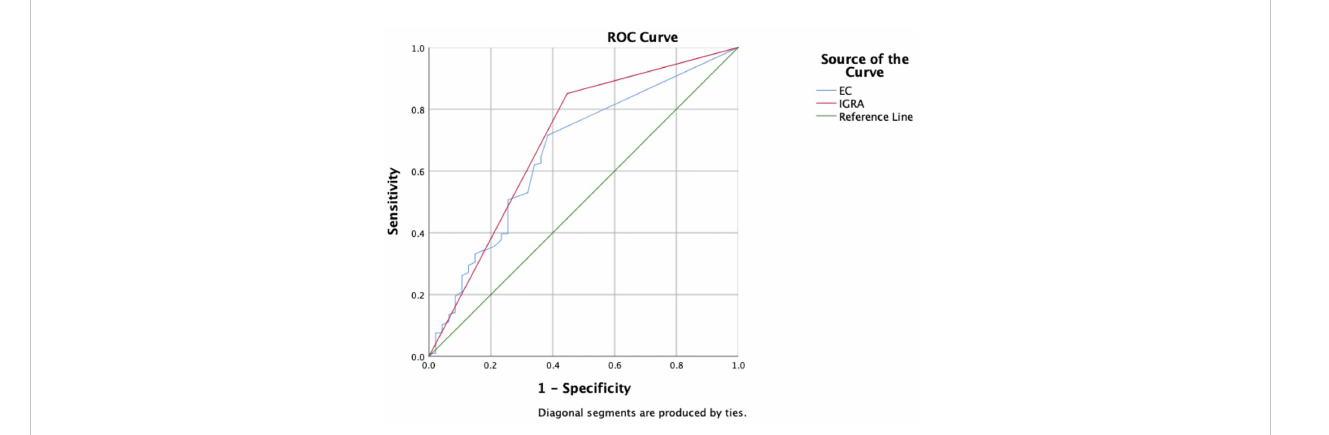
FIGURE 2 Receiver operating characteristic curves of the ECST and IGRA tests in patients with clinically diagnosed tuberculosis.